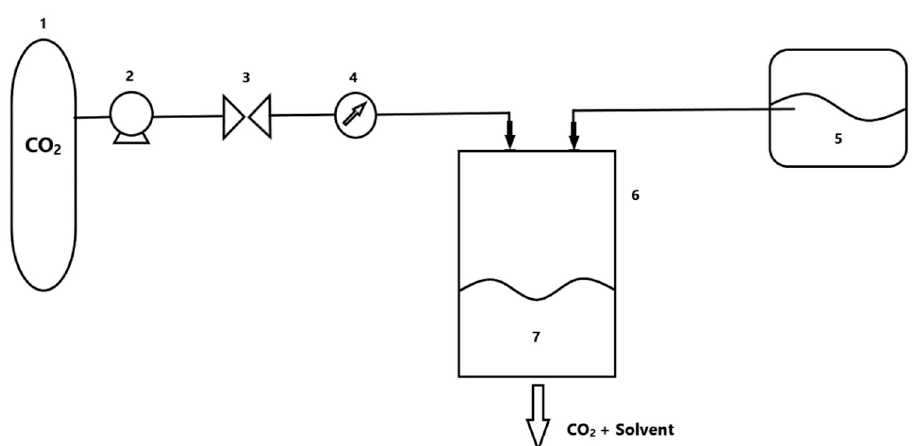
Figure 4. Supercritical antisolvent (SAS) process installation diagram. Legend: (1) CO 2 tank; (2) pump; (3) valve; (4) temperature control; (5) tank with organic solvent; (6) separating tank; (7) precipitated crystals.